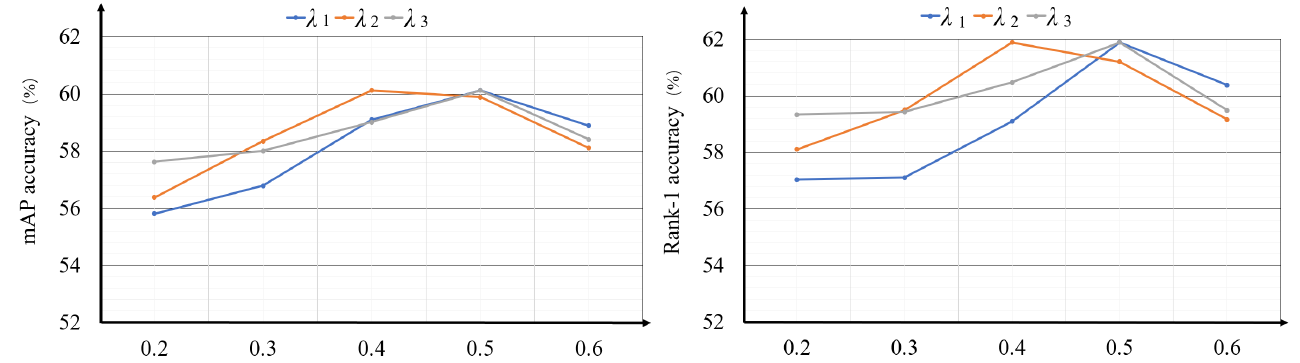
Figure 6. The influence of the trade-off parameters λ 1 , λ 2 and λ 3 in mAP accuracy and Rank-1 accuracy.